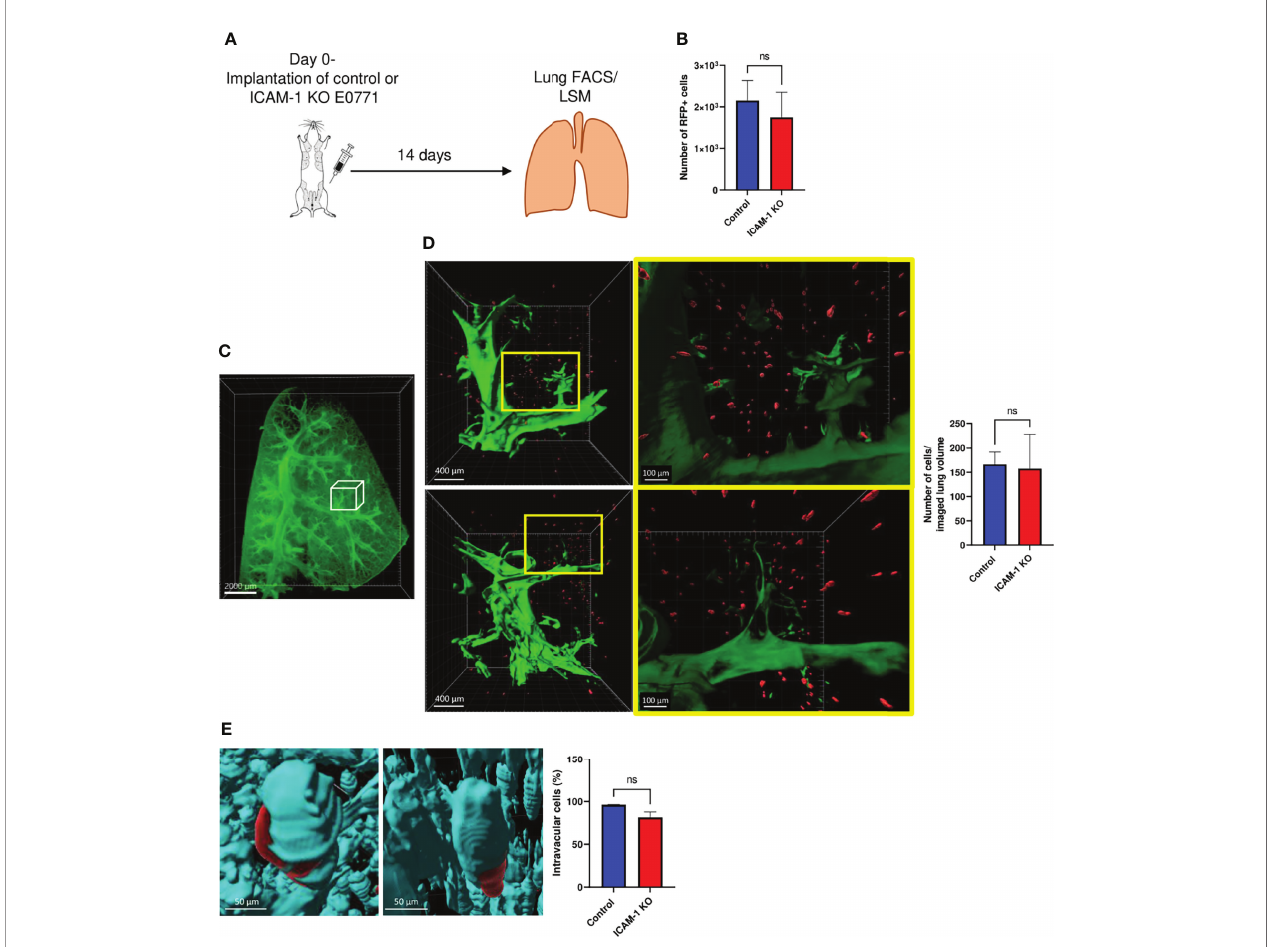
FIGURE 4 | Dissemination and early accumulation inside the blood vessels of E0771 breast cancer cells are not affected by their ICAM-1 expression in a spontaneous model of metastasis to lungs. (A) A scheme depicting the experiment. 3 × 10 5 control or ICAM-1 KO RFP-expressing E0771 cells were implanted in the mammary fat pads of recipient mice. Two weeks later, lungs were harvested and processed for either the FACS analysis of total cell suspensions or for the fi xation and clearance of lungs for imaging by three-dimensional (3D) light sheet fl uorescence microscopy (LSM). For imaging, mice were intravenously stained with Alexa fl uor 647 labeled CD31 mAb injected i.v. 15 min before euthanasia and lung harvesting. (B) The number of RFP-positive E0771 cells recovered in the lungs determined by FACS. n=4. (C) A representative LSM image of a whole lung lobe taken from Movie 8 . The white cube represents the lung volume (2,160 µm × 2,560 µm × 2,000 µm) imaged in D. (D) A representative LSM image of RFP cells disseminated from the primary breast tumor and accumulated in the lung lobes. Green: lung auto- fl uorescence. Red: E0771 cells in the imaged cube depicted in C, representative of four lung lobes isolated from two mice. The right images are the magni fi cations of the yellow rectangles marked in the middle images. Top images: control E0771 cells. Bottom images: ICAM-1 KO E0771 cells. The spots representing the RFP signal were <3,000 µm 3 in volume. The bars in the right panel depict the average number ± SEM of control and ICAM-1 KO E0771 cells (spots) detected in 4 lung cubes (2,160 µm × 2,560 µm × 2,000 µm in dimension). (E) The left and right images depict, respectively, individual control and ICAM-1 KO E0771 cells (red) and CD31-labeled lung vessels (cyan). Images were taken from the LSM-analyzed lung samples represented by the examples in Movie 3 . The bars in the right panel depict the percentage of control or ICAM-1 KO E0771 cells detected inside the CD31-labeled lung vessels. The bars in (B, D , E) depict the mean values ± SEM of the same 4 lung cubes analyzed in